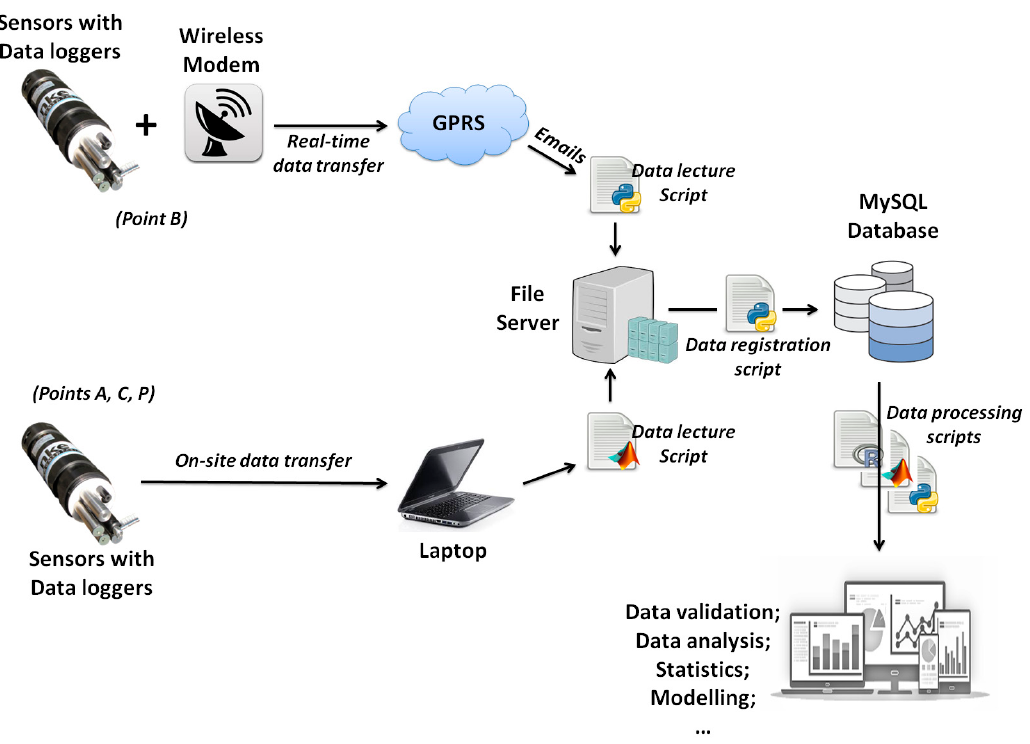
Figure 3. Schemes of the data transfer platform.